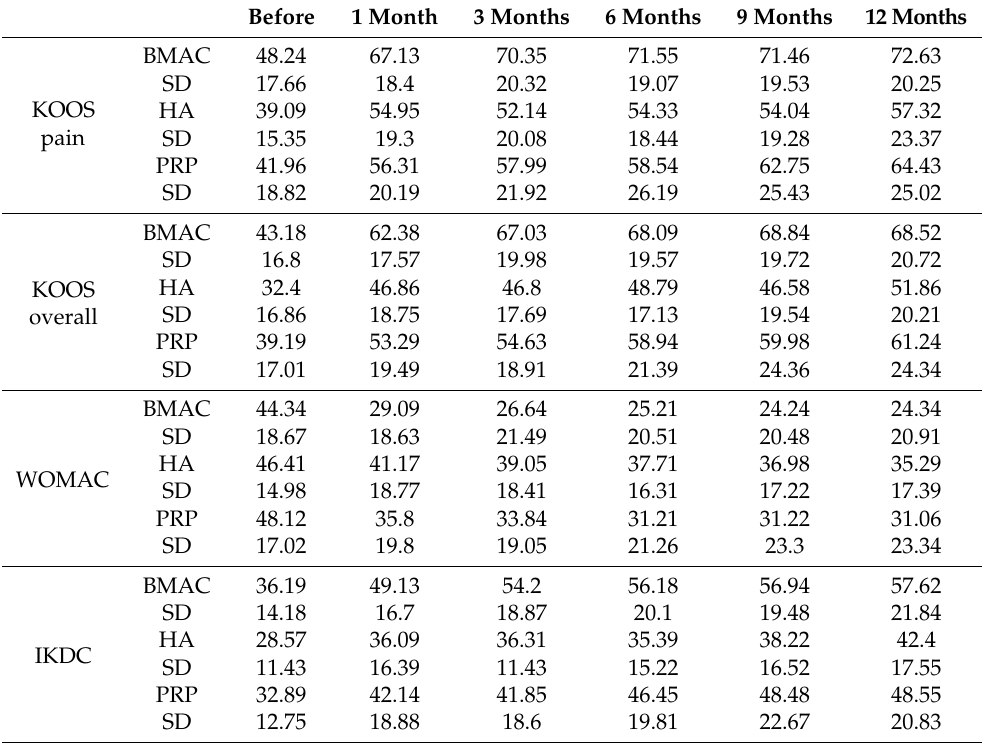
Table 3. Values of clinical scores in intervention groups over